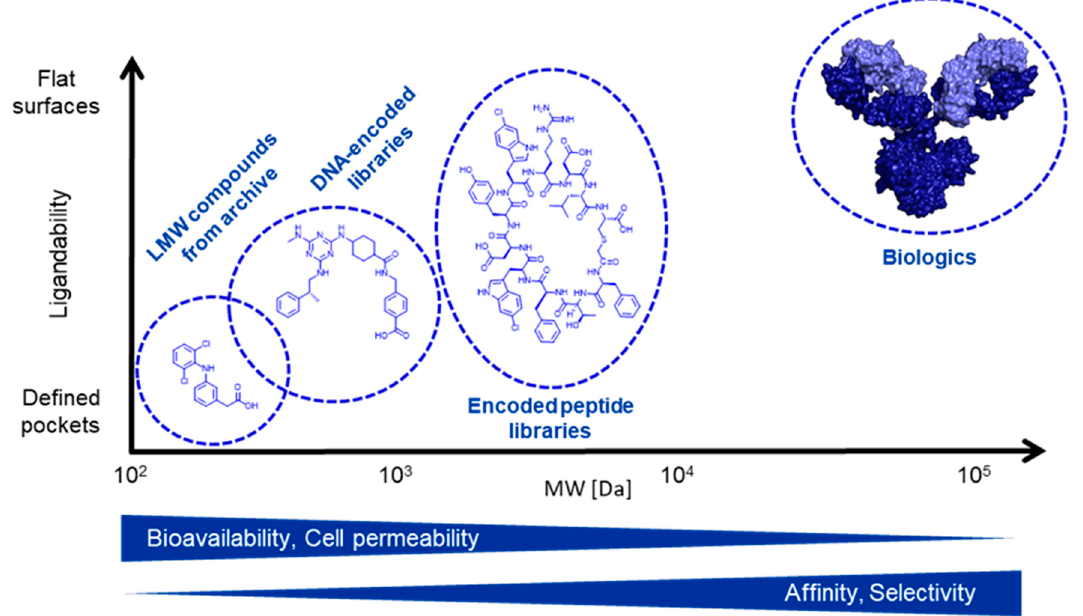
Figure 1. Model of chemical space available for hit finding and positioning of the encoded library technologies DEL and PDP. While those ligands on the left typically have a higher bioavailability and cell permeability due to their smaller size, this gets less and less pronounced towards larger molecular weights. In contrast, bigger molecules like peptides and biologics most often possess higher affinities and selectivities towards their targets compared to LMW compounds. The typical numbers of library sizes are about 10 6 for archive-based compound collections, about 10 9 for DELs, 10 12 for peptide libraries and about 10 10 for biological agents.